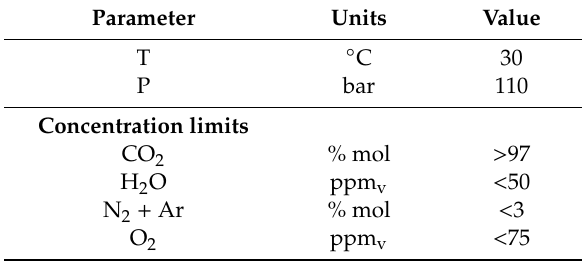
Table 2. Product CO 2 specification for Enhanced Oil Recovery (EOR)